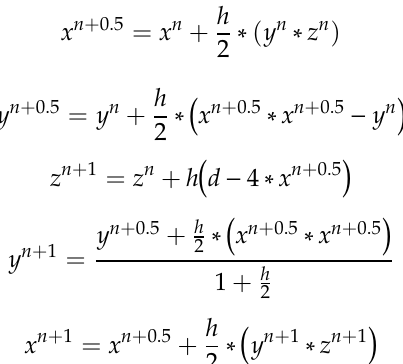
Table 5. Parameters used in experiments with the Sprott Case E system. Order 3 4 6 Step values, sec.